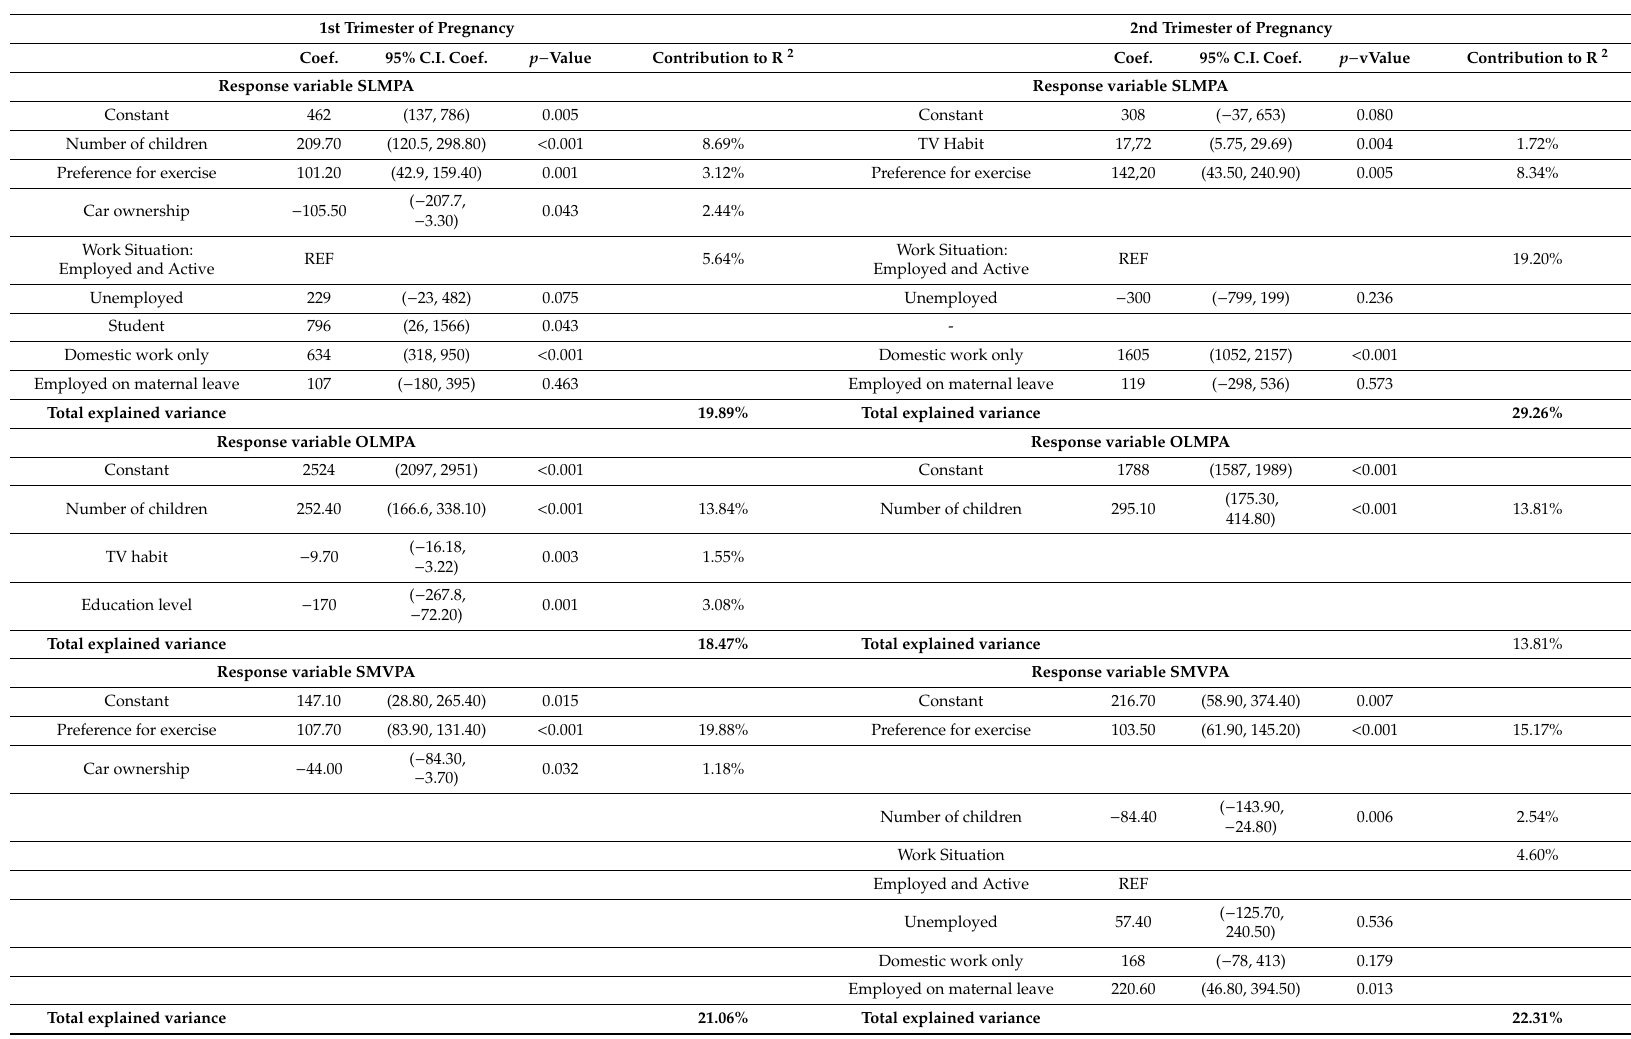
Table 3. Predictive models of SLMPA, SMVPA, OLMPA and OMVPA for the first and second trimesters of pregnancy. 1st Trimester of Pregnancy 2nd Trimester of Pregnancy